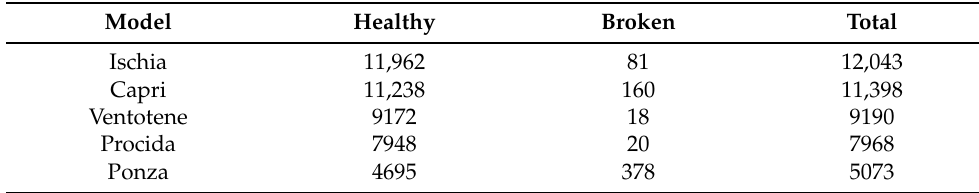
Table 1. The composition of the dataset.